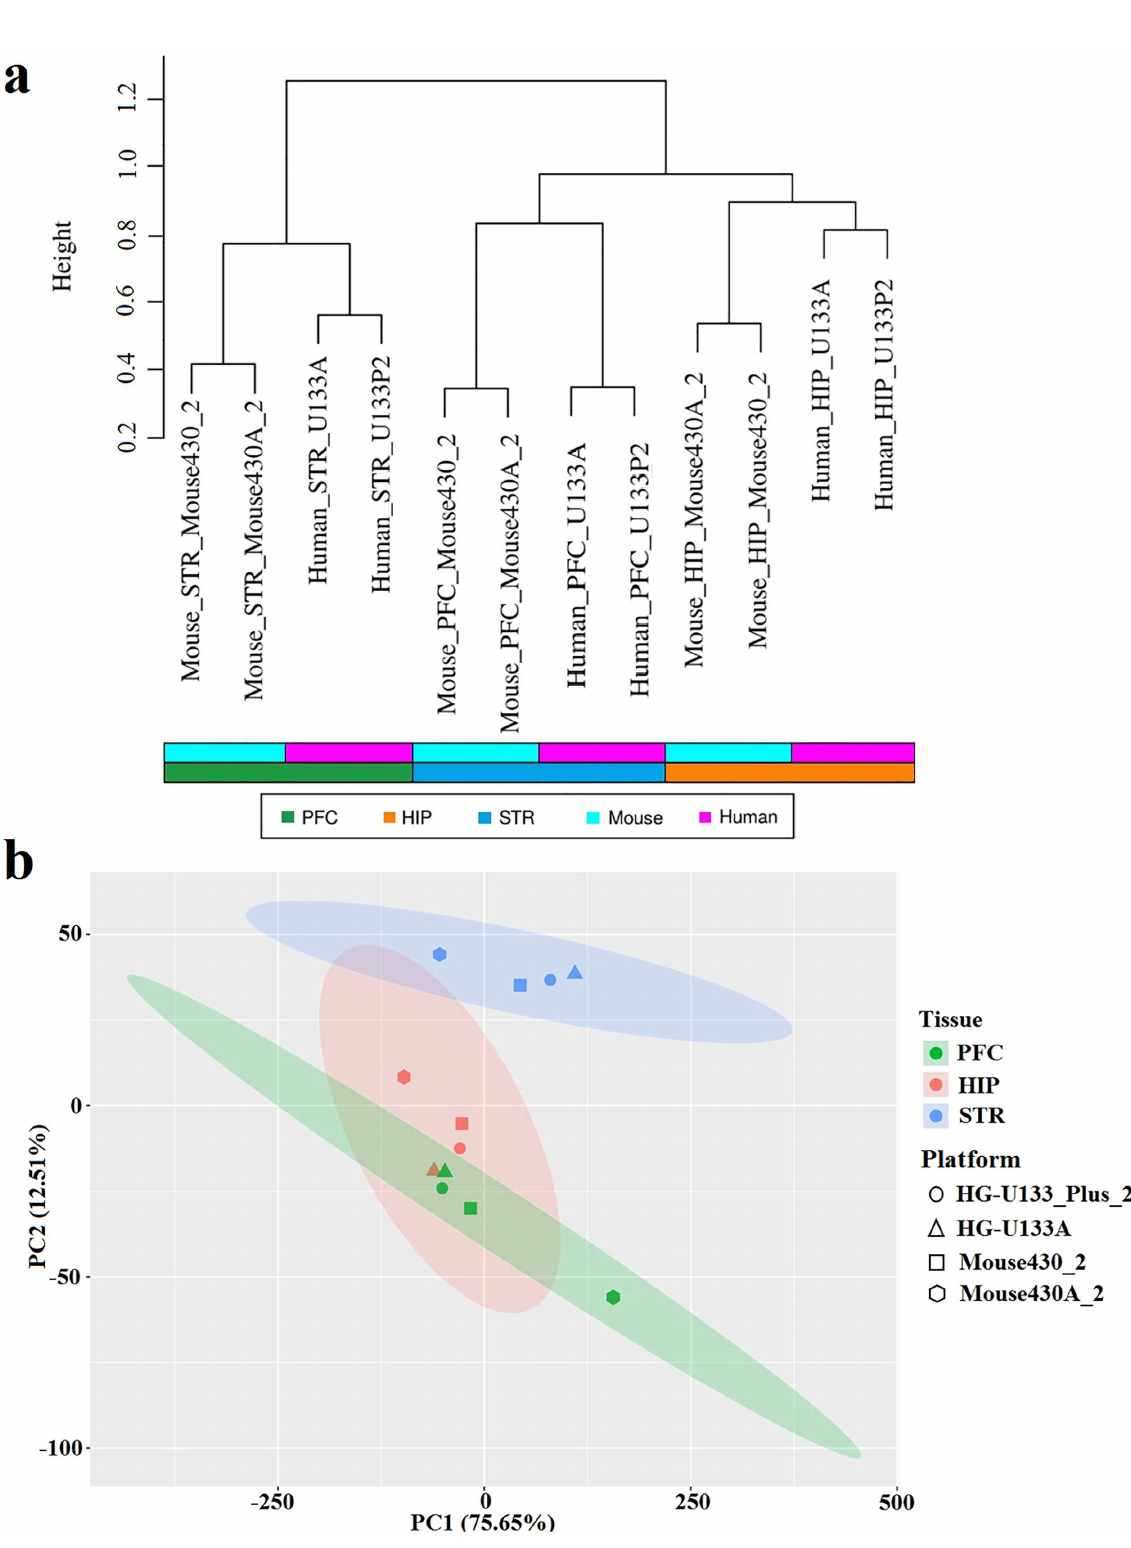
Fig 3. Gene expression pattern analysis. (a) Hierarchical clustering dendrogram of the 12 datasets (distance metric: “1-P”, linkage method: complete). The color bars below the dendrogram provide information about the species (upper bar) and the datasets (lower bar). (b) Principal component analysis(PCA) of the 12 datasets. Brain tissues are labeledby different colors (green = PFC; red =